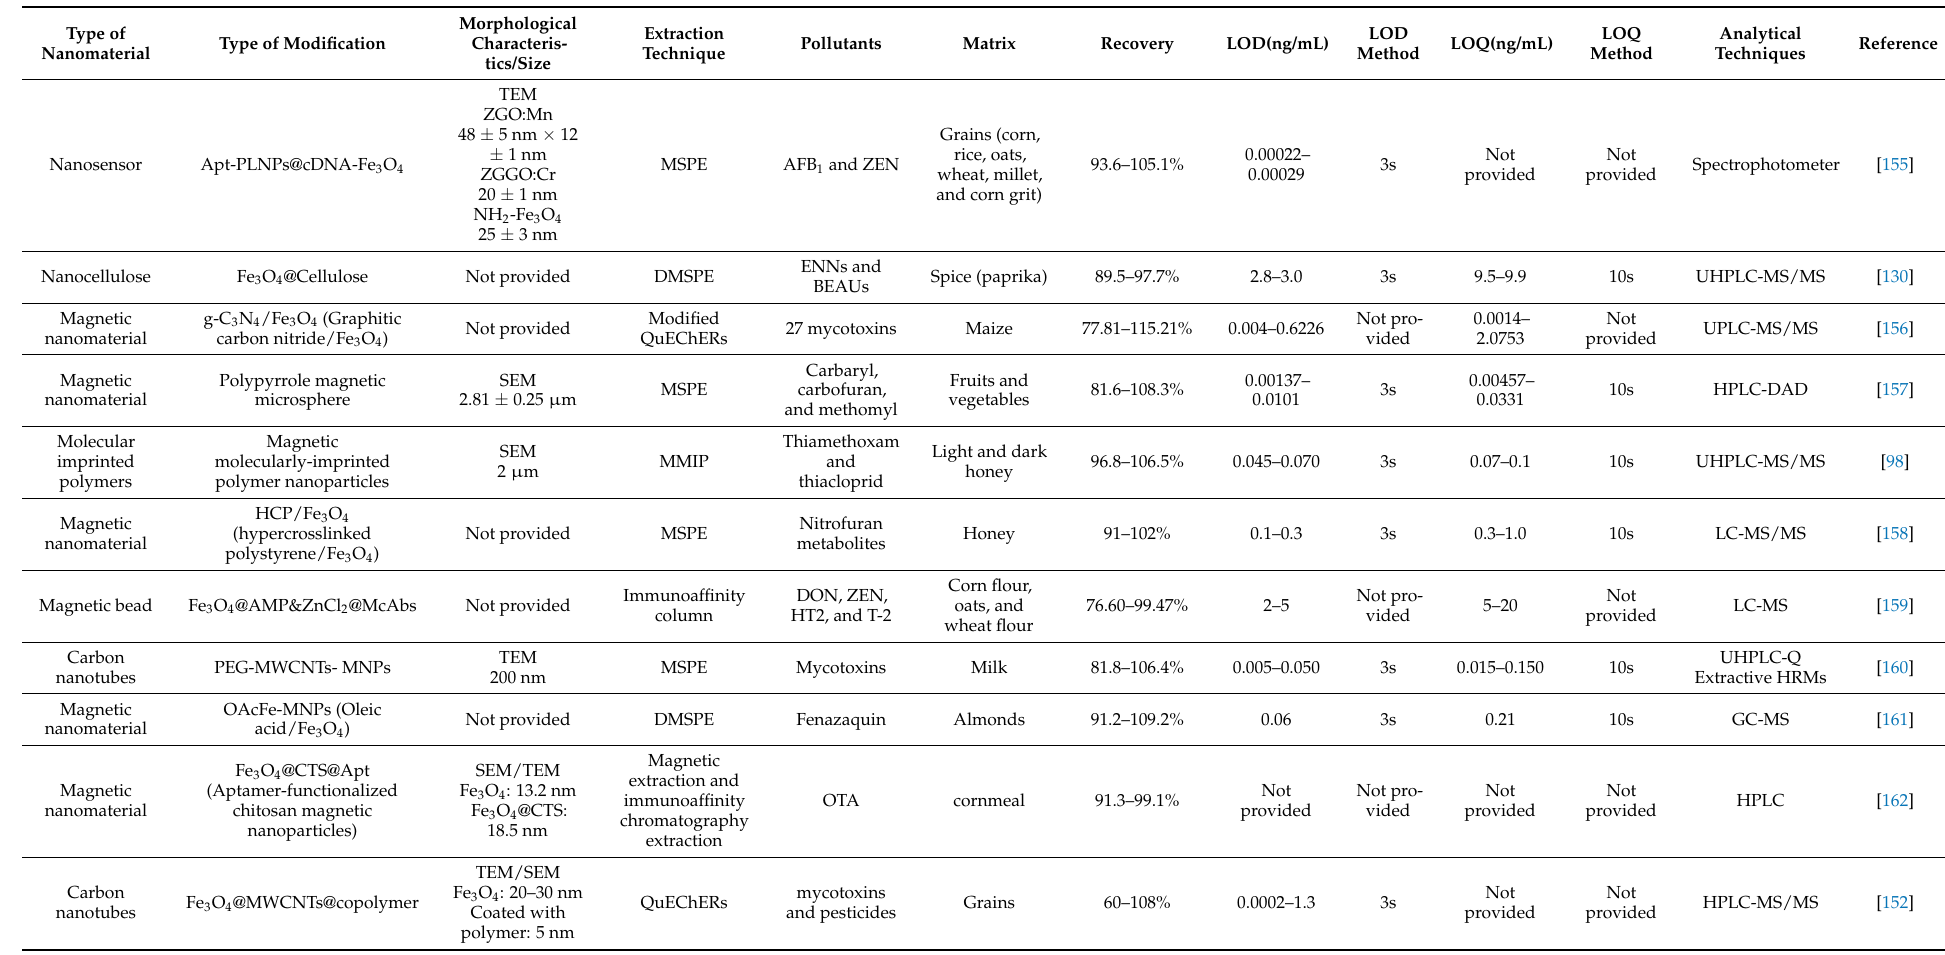
Table 2. Current applications of MNMs in extracting pollutants from food